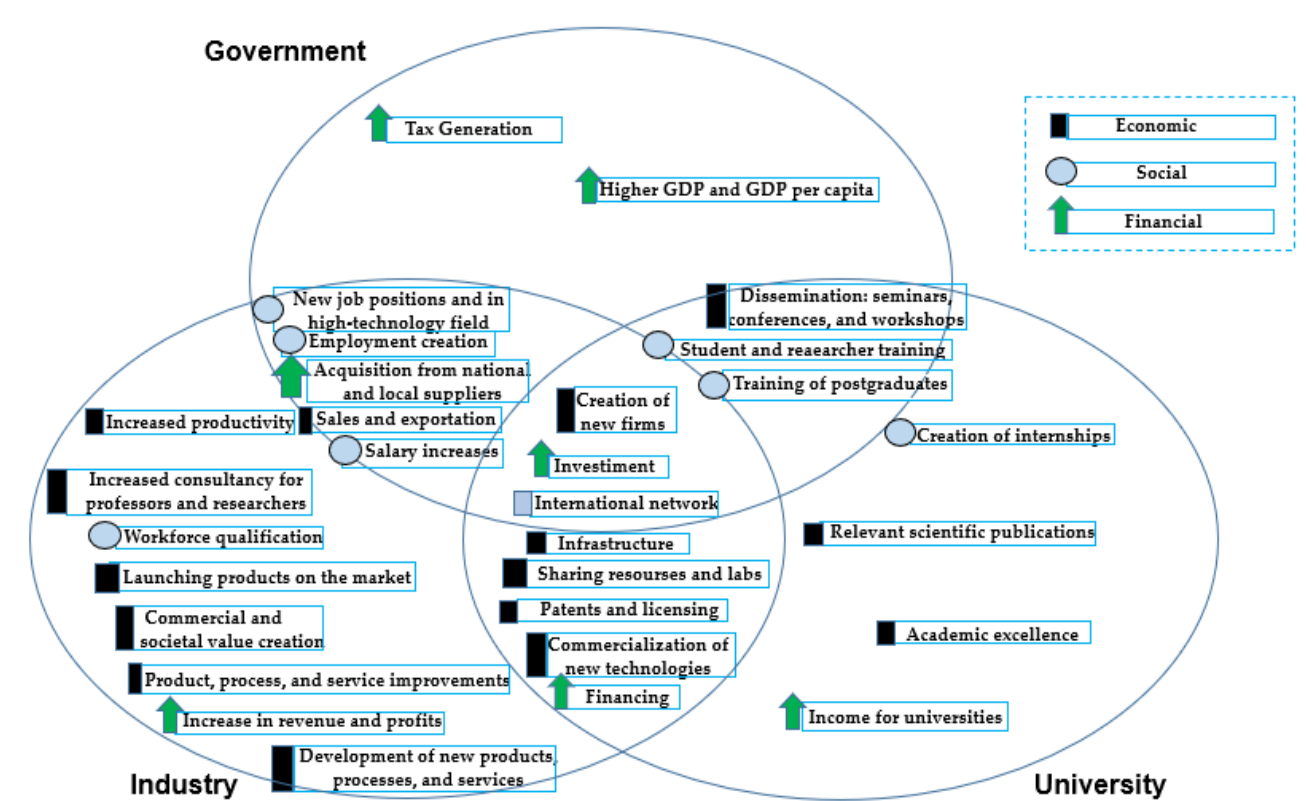
Figure 6. Socioeconomic triple helix.